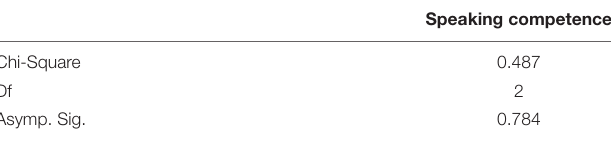
TABLE 4 | Results of Kruskal–Wallis test